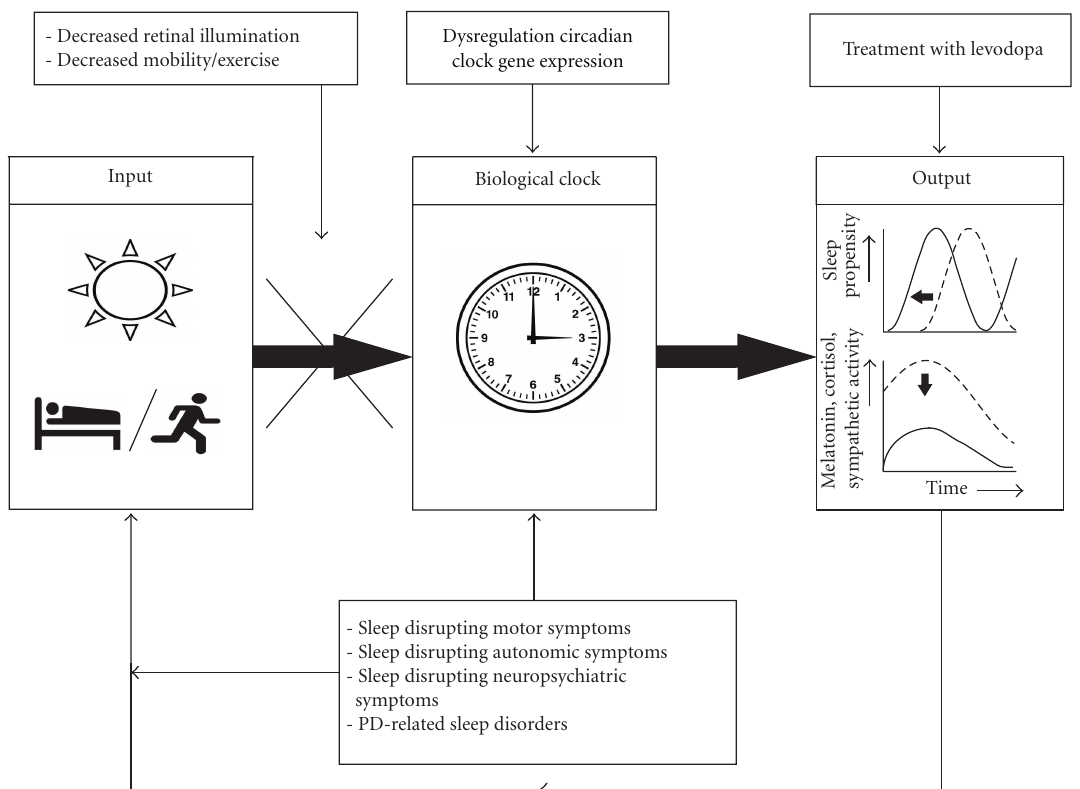
Figure 1: The input of the biological clock by zeitgebers is both decreased and conflicted due to various motor and non-motor symptoms in PD. Dopamine depletion due to PD disrupts circadian clock gene expression, and its treatment with levodopa influences both sleep structure and sympathetic activity. These factors all alter output of the biological clock: there is a phase advance and flattening of the circadian rhythm as displayed by hormone levels and sympathetic activity. In turn, the alteration of circadian rhythmicity has a negative influence on (input of) the biological clock, leading to a downward spiral resulting in sleep disturbances and